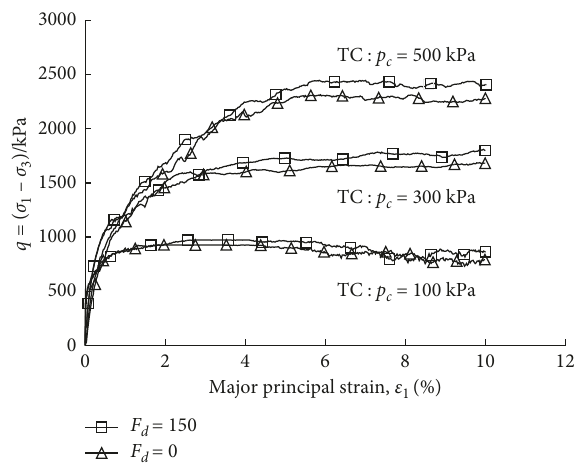
Figure 18: Effect of the particle shape on shear strength.